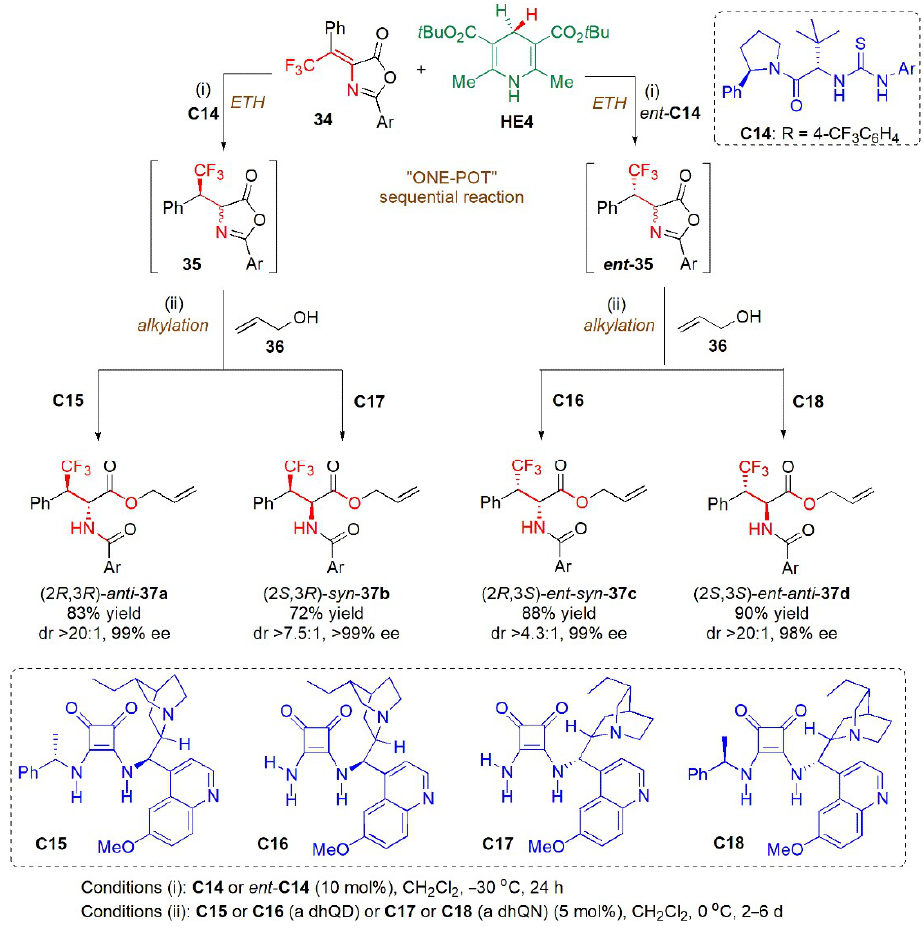
Figure 15. One-pot diastereodivergent, enantioselective synthesis of the stereoisomers of 37 with different catalyst combinations